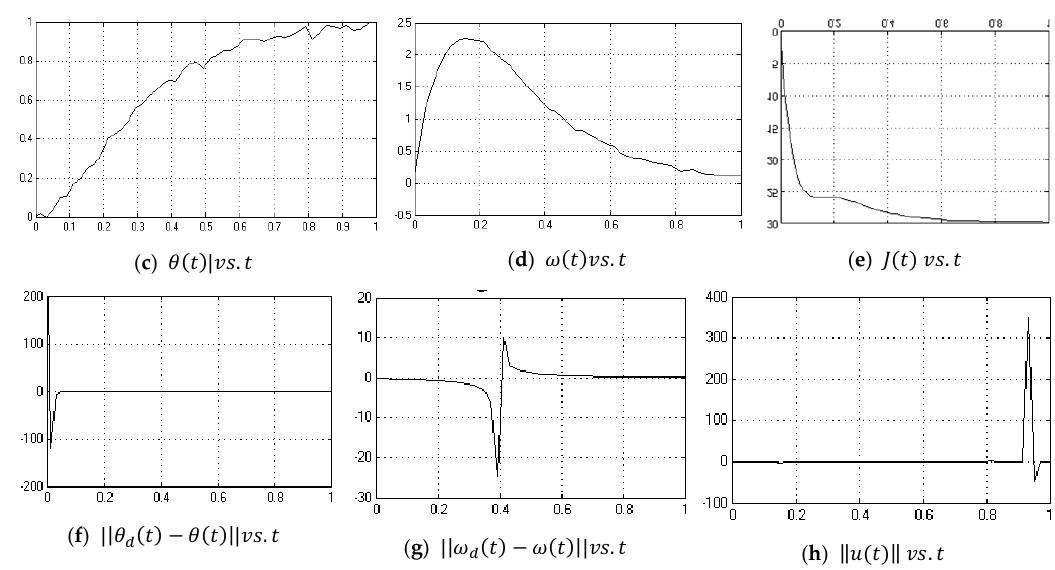
Figure A4. Proportional ‐ derivative (PD) controller ( 𝐾 (cid:3050) (cid:3404) (cid:3398)13.3,𝐾 (cid:3044) (cid:3404) 40 ) simulation model with noise.